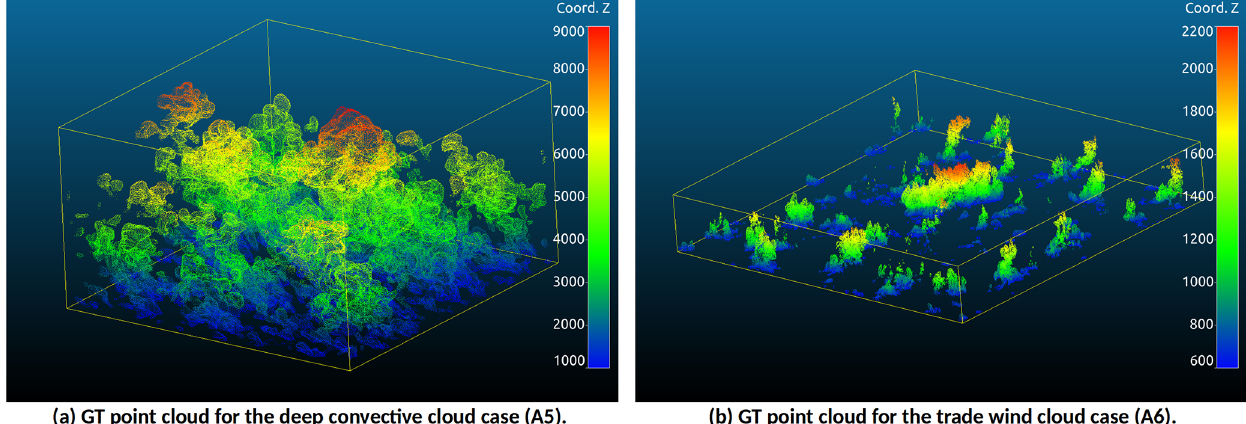
Figure 7. 3D cloud envelope referred to as GT (ground truth) point clouds. Point colour shows the Z coordinate (altitude from ground expressed